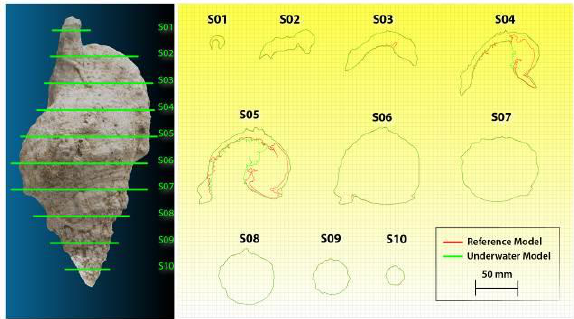
Figure 9. Cross sections